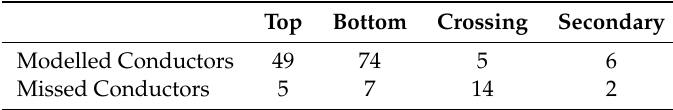
Table 10. Final output on extended Gilberthorpes dataset using 2-Dimensional Mean Shift Clustering with a bandwidth of 4